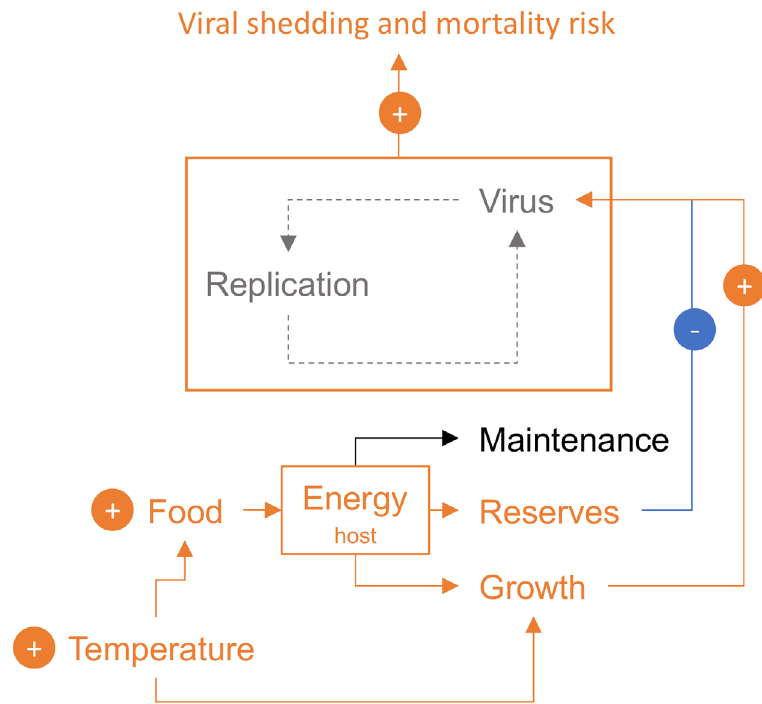
Fig. 8. Food availability acts both as an enabling factor for mortality by increasing oyster growth and virus replication, likely providing materials for virus construction, but also as a limiting factor by increasing energy reserves of the host. The net effect of food availability is an increased risk of mortality of oysters exposed to the virus. Temperature increases both growth rate and food ingestion, and thus favours viral replication and shedding in seawater and mortality risk in the host population. Orange, blue and black lines indicate positive, negative and neutral feedback, respectively, dashed grey lines indicate virus replication in the